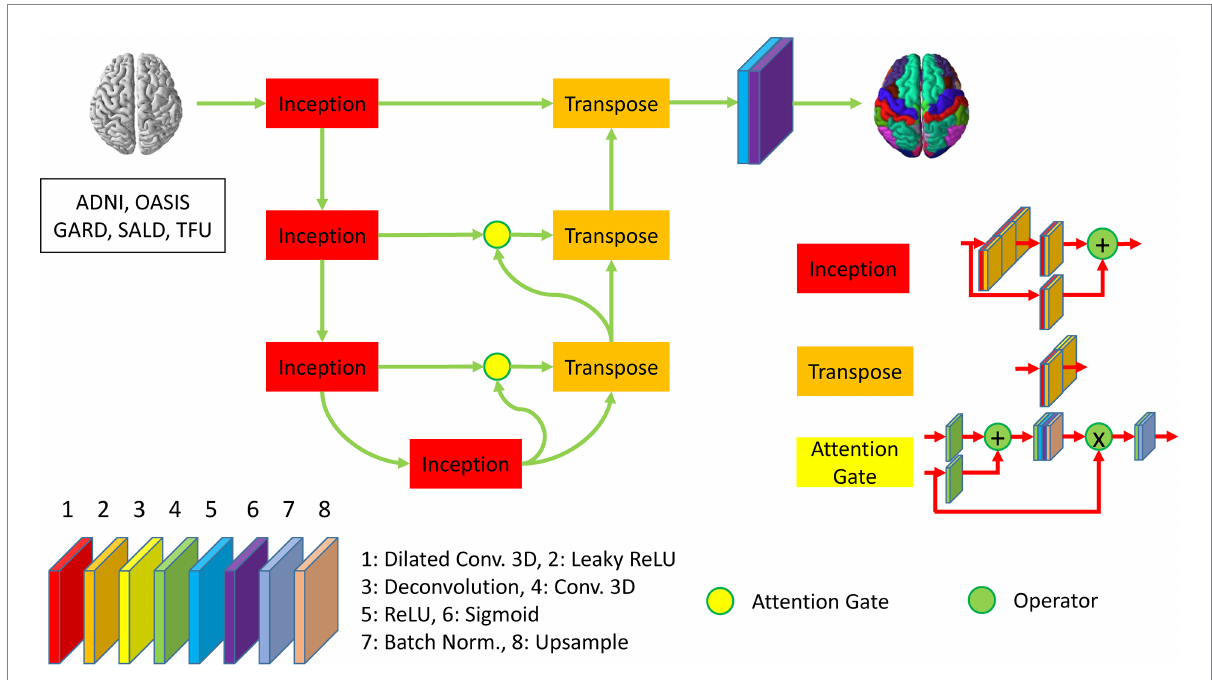
FIGURE 1 Description of DeepParcellation network architecture for a single region of interest. The network includes four inception blocks and three transpose blocks, which consist of eight different layers. The second, third, and fourth inception blocks are connected to transpose blocks through attention gates. The last transpose block is activated through ReLU and Sigmoid function to predict parcellated brain